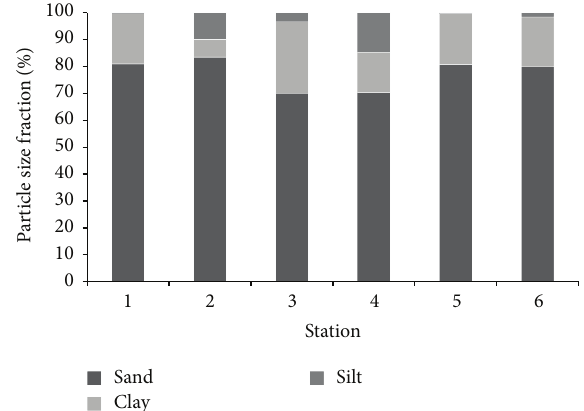
Figure 4: Particle size fraction of sediment collected at the six sam- pling stations located at the upper reaches of two main tributaries of Batang